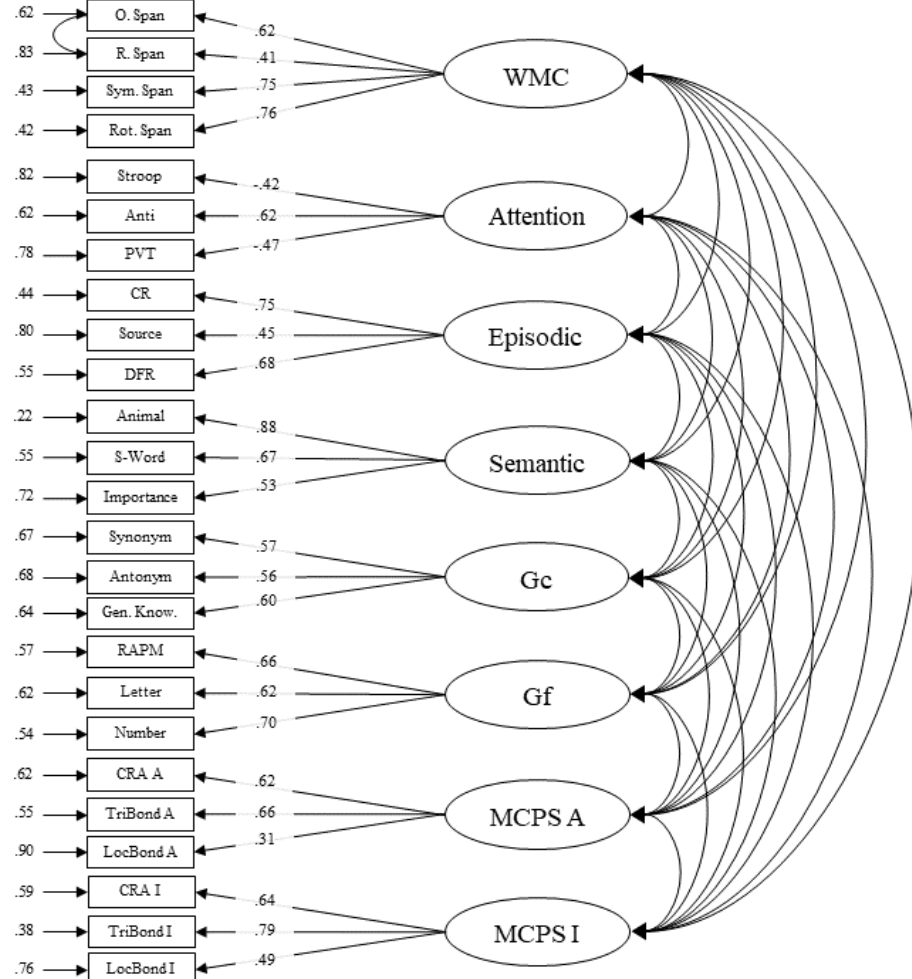
Figure 4. Confirmatory factor model (3) that was retained after fit comparisons. Single-headed arrows on the left-side of boxes (manifests) represent error variance. Single-headed arrows from circles (latent factors) to boxes (manifests) represent the standardized factor loadings. PVT: Psychomotor Vigilance; CR: Cued Recall; DFR: Delayed Free Recall; RAPM: Raven’s Progressive Matrices; WMC: Working Memory Capacity; Gc: crystallized intelligence; Gf: Fluid Intelligence. The “A” in CRA A, TriBond A, LocBond A, and MCPS A stands for analytical, while the “I” in CRA I, TriBond I, LocBond I, and MCPS I stands for insight. Table 6. Latent factor correlations between working memory capacity (WMC), attention control (Att), episodic memory (Epi), semantic memory (Sem), crystallized intelligence (Gc), fluid intelligence (Gf), and multiply-constrained problem solving (MCPS).